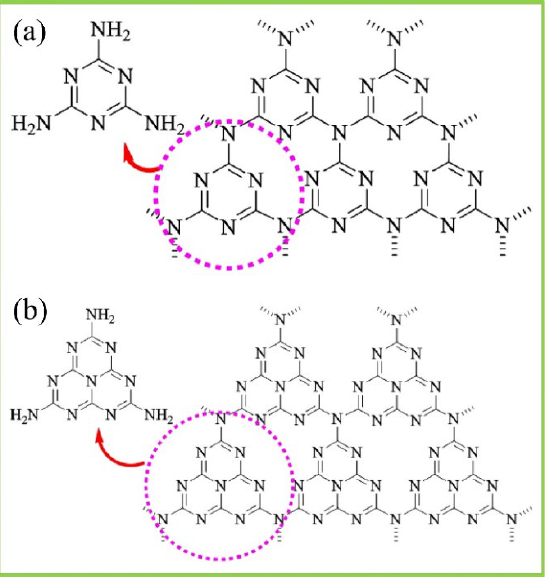
Figure 7. Structures of g-C 3 N 4 : ( a ) s-triazine based, and ( b ) tri-s-triazine based. Reproduced with permission from [184].